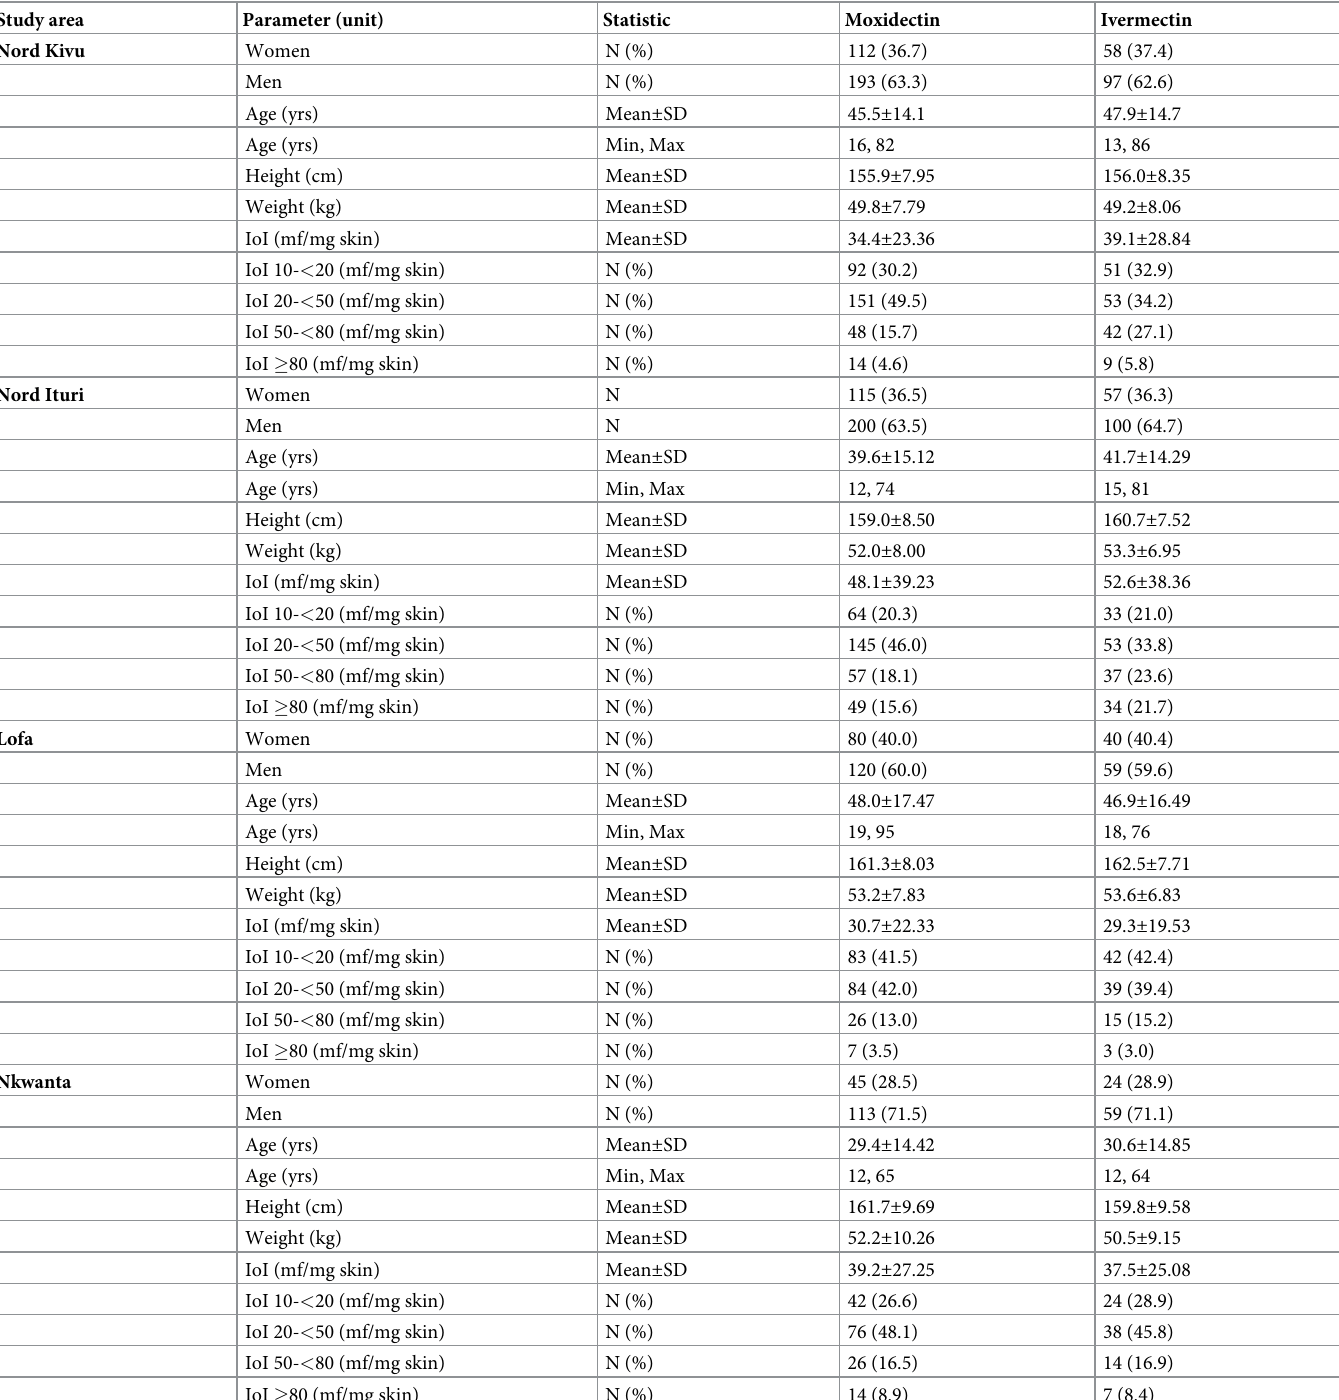
Table 1. Demographics and intensity of infection of enrolled study participants by study